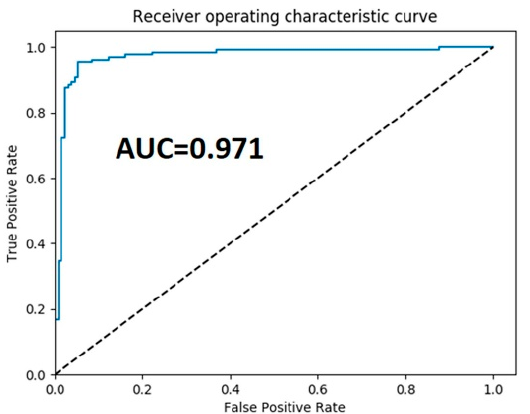
Figure 8. The receiver operator characteristics curve of the proposed framework.